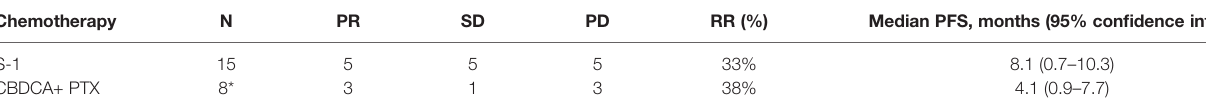
TABLE 3 | Ef fi cacy of second- or later-line regimen.